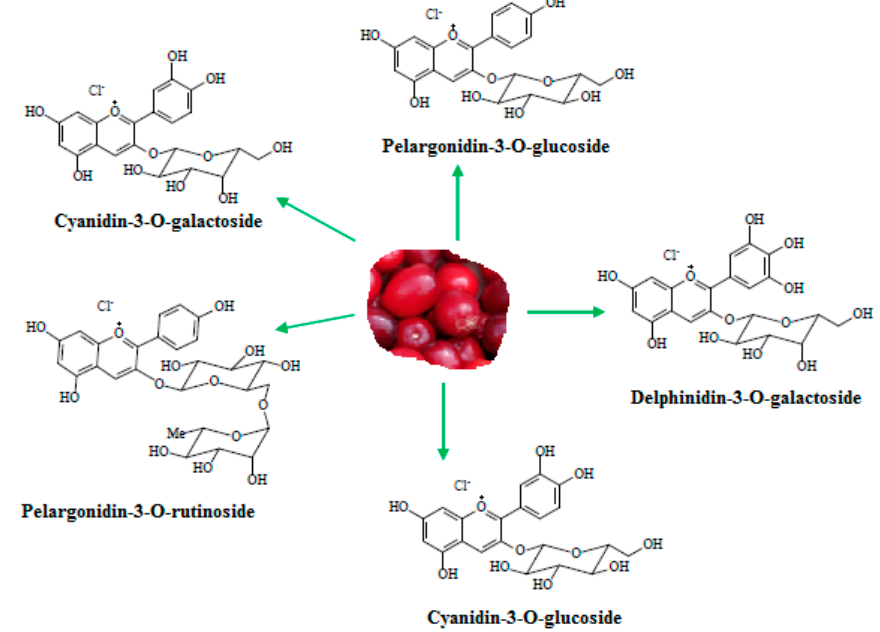
Figure 1. Structure of anthocyanins from Cornelian cherry fruit.